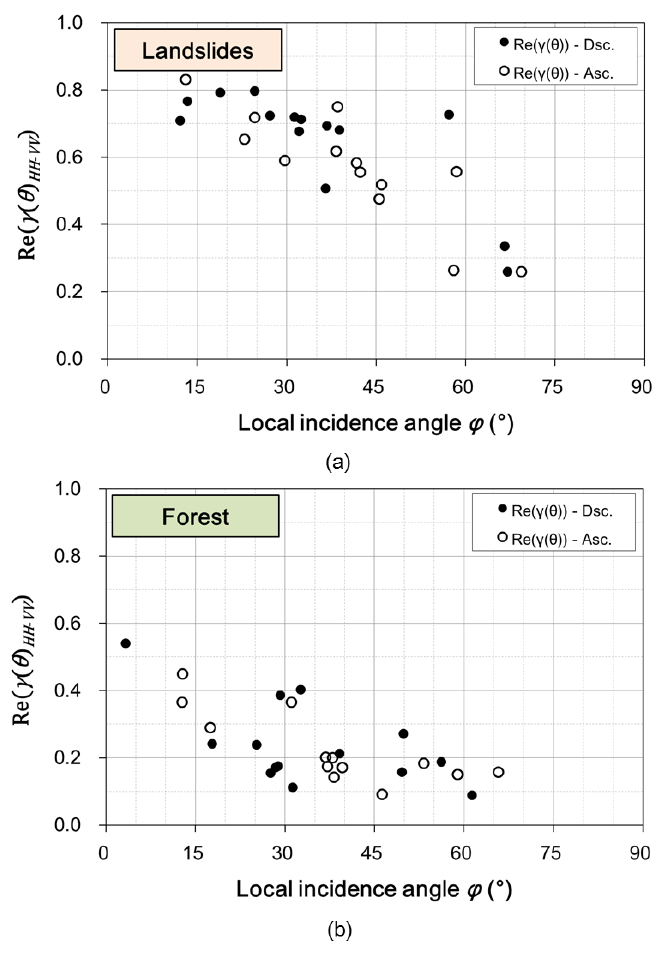
Figure 10. The HH-VV correlation coefficient with respect to the local incidence angle in ( a ) landslides and ( b ) forested areas for PALSAR-2 data acquired with ALOS-2 from its descending and ascending